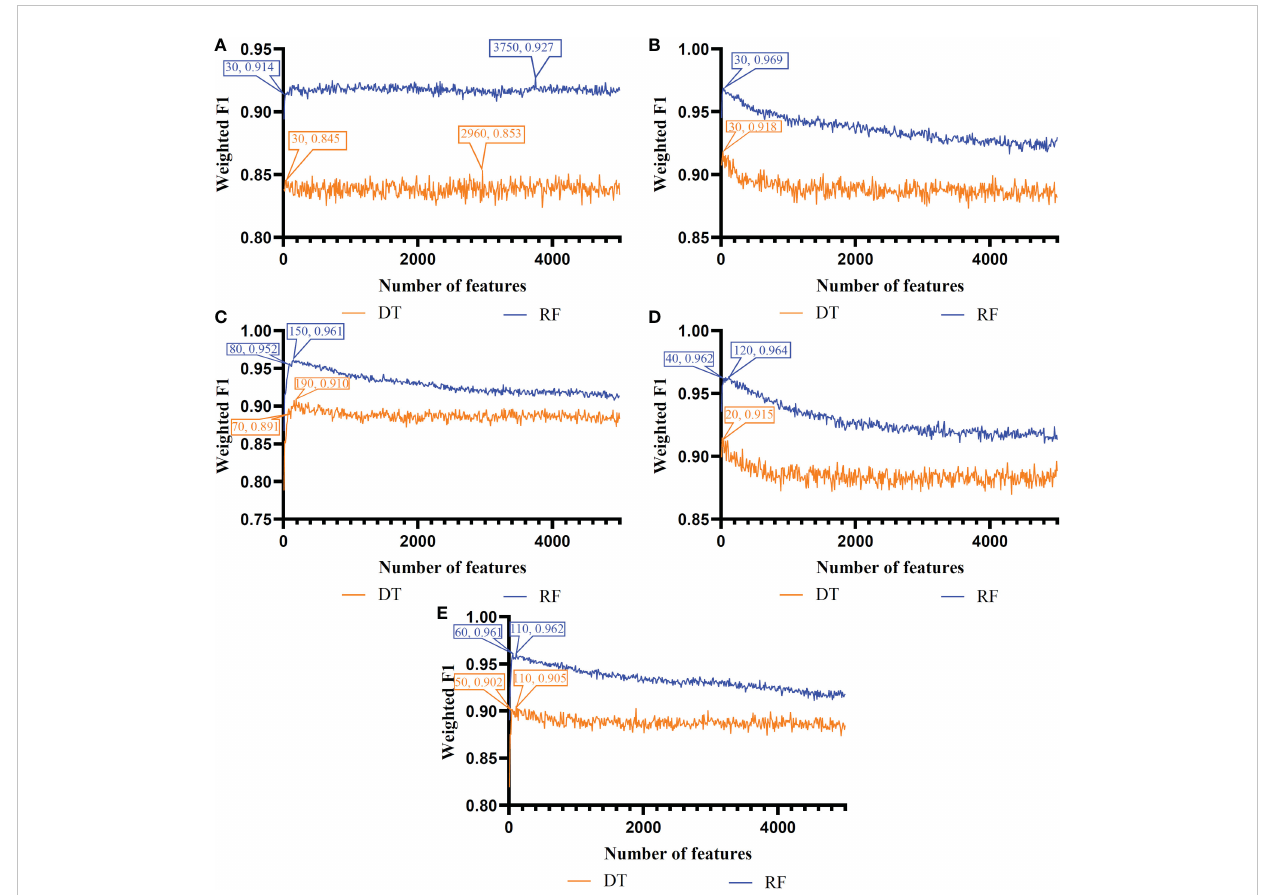
FIGURE 2 Incremental feature selection (IFS) curves of two classi fi cation algorithms in B cells. (A) IFS results obtained based on the LASSO gene list. (B) IFS results obtained based on the LightGBM gene list. (C) IFS results obtained based on the mRMR gene list. (D) IFS results obtained based on the MCFS gene list. (E) IFS results obtained based on the PFI gene